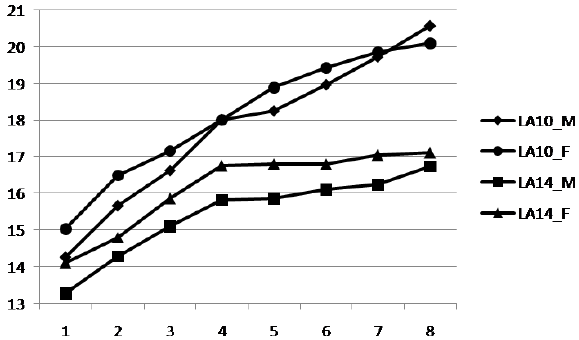
Figure 2. Changes in ultrasonic M. longissimus area as functions of scans in pigs of the Iberian